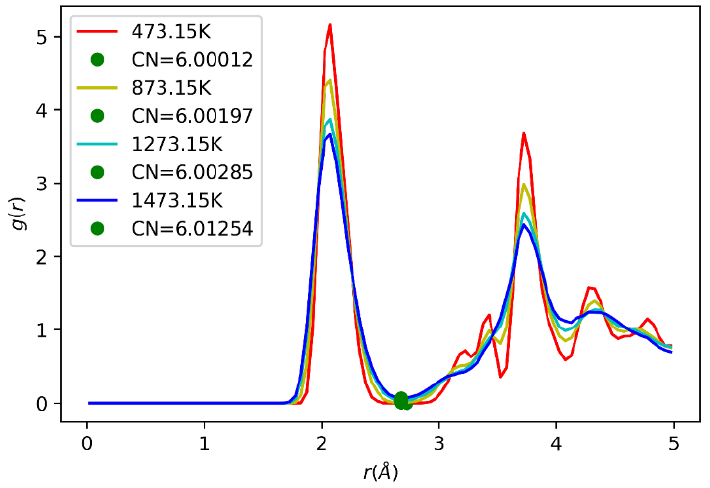
Figure 3. Zirconium radial distribution function as modeled by Kilo ’ s potential.